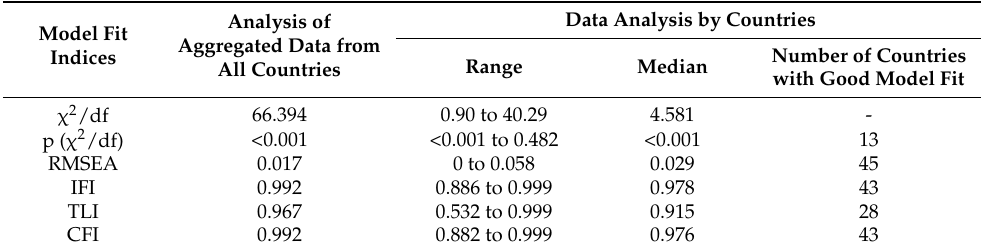
Table 7. Summary of model fit to data of 45 HBSC